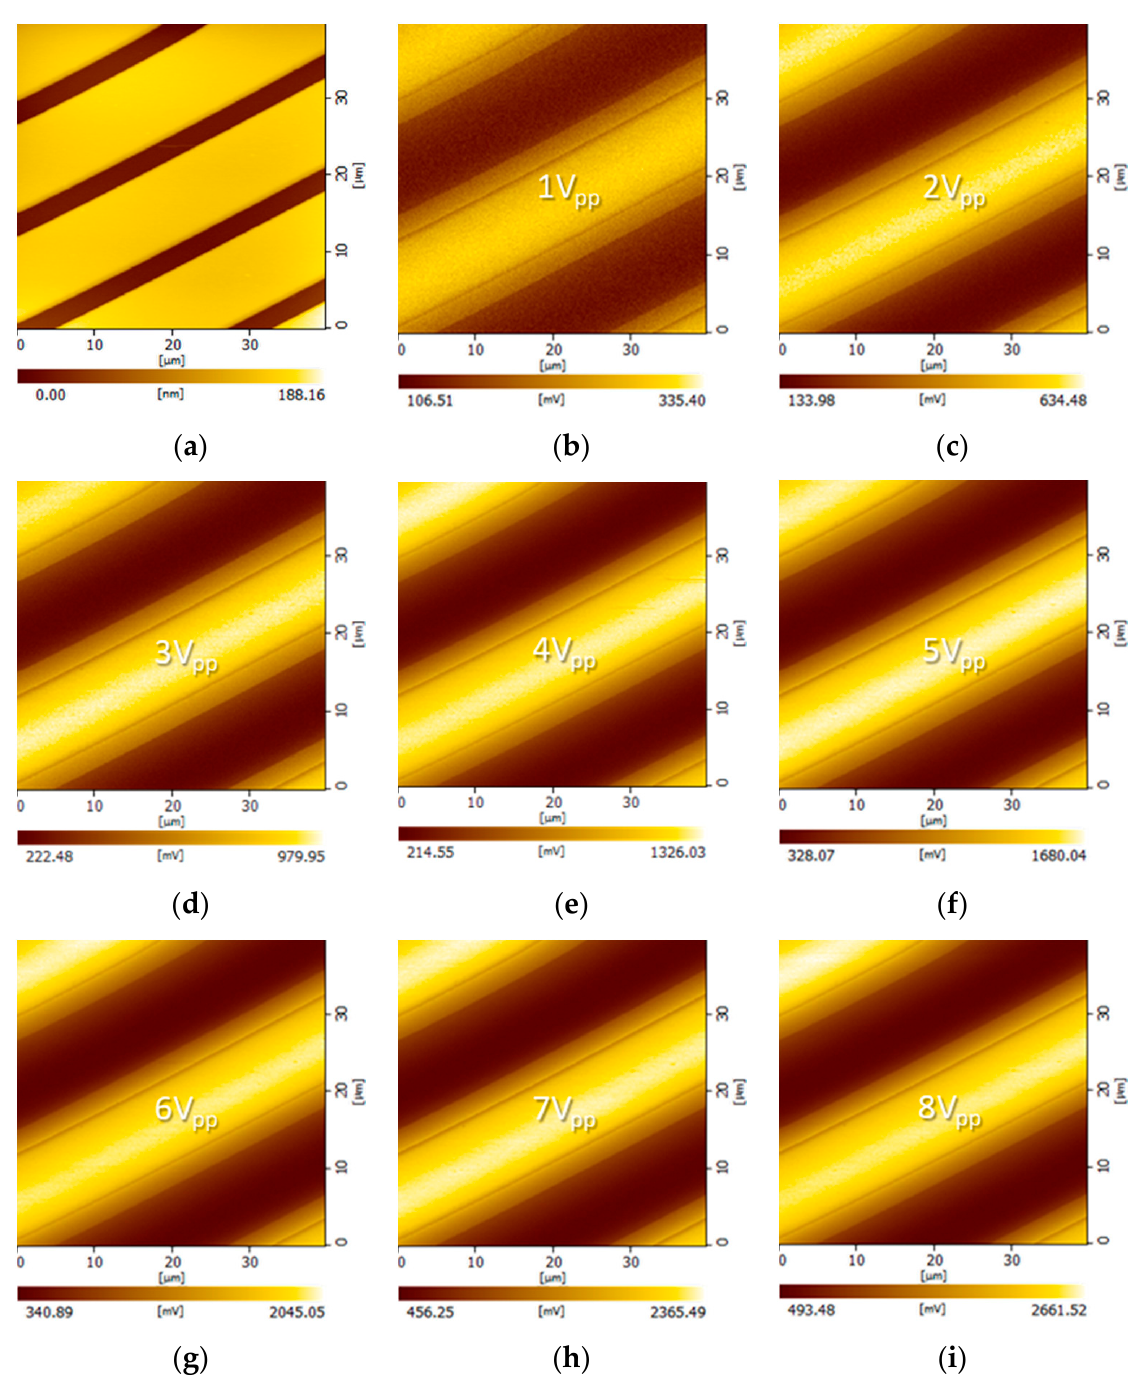
Figure 4. ToGoFET images of interdigitated electrodes covered with 400-nm-thick oxide: ( a ) the topographic image; ( b – i ) electrical images were obtained at various voltages with a driving frequency 100 kHz.